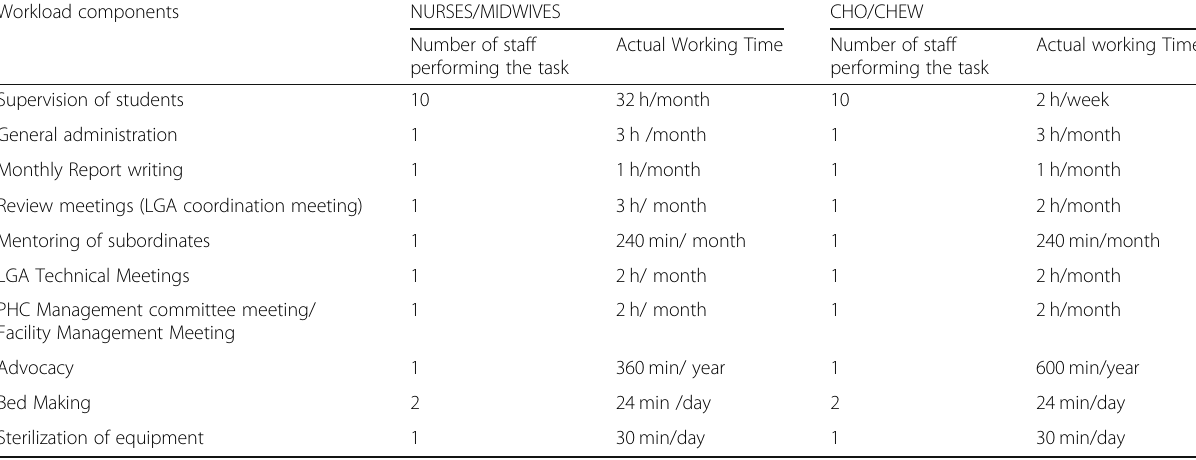
Table 4 Validated additional activities and individual allowance standard for primary healthcare centre Workload